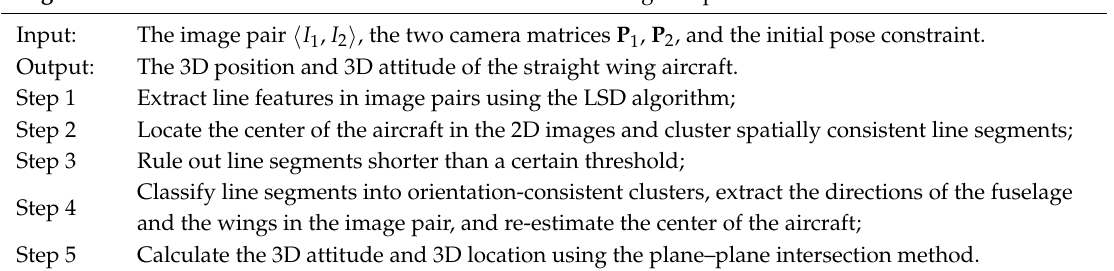
Algorithm 1: Pose estimation based on consistent line clustering and planes intersection